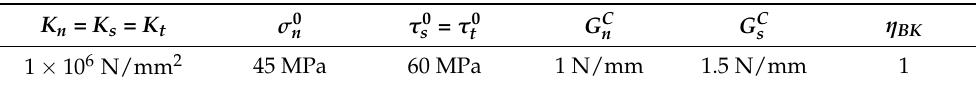
Table 4. The parameters of the bilinear cohesive region model at room temperature. K n = K s = K t